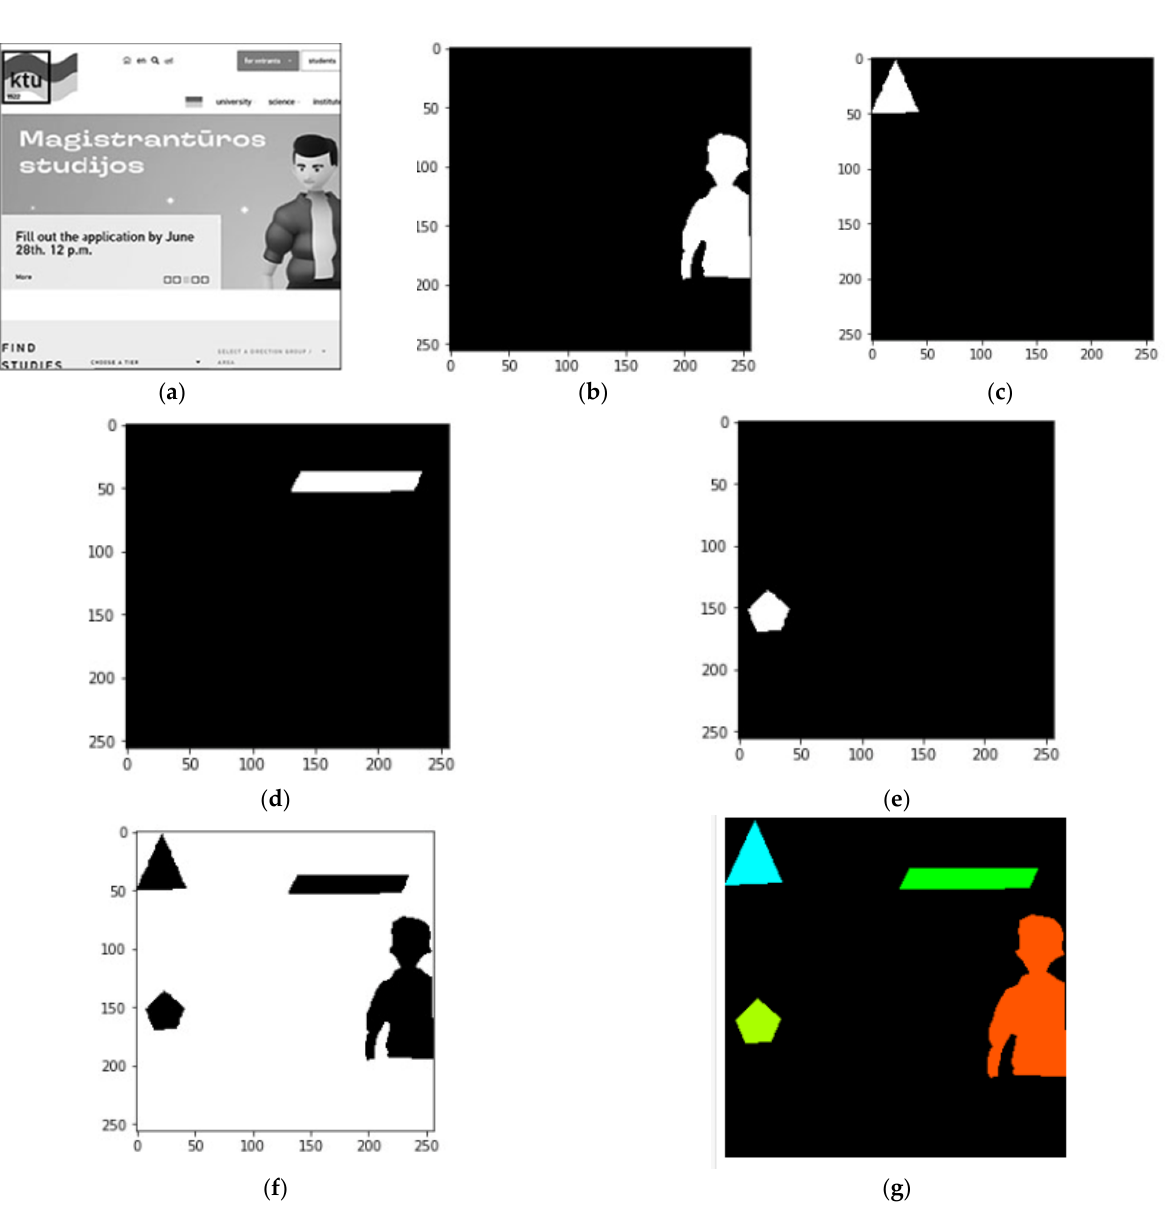
Figure 2. Multi-classification image with respect to labels: ( a ) webpage screenshot image, ( b ) seg- mented image, ( c ) segmented logo, ( d ) segmented header, ( e ) segmented paragraph text, and ( f ) all defined labels together, with background in white, and ( g ) all labels in the segmented RGB image.